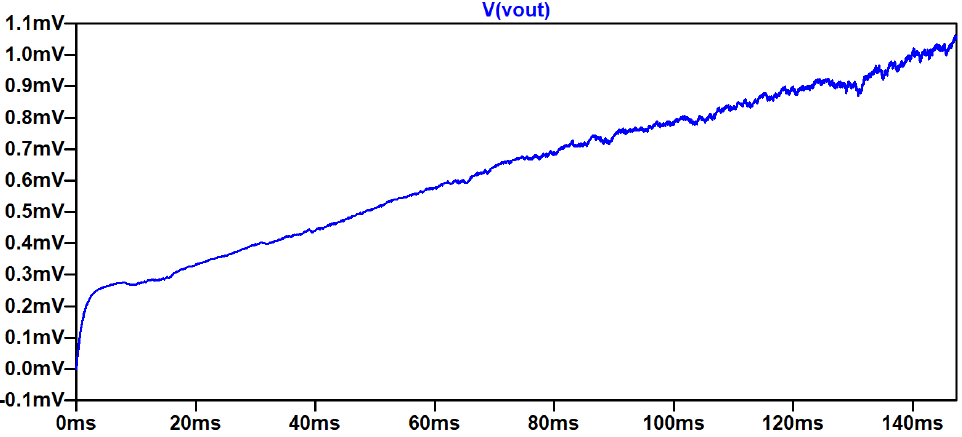
Figure 12. The output-voltage response of the circuit with Si MOSFET as switch and RC load at output.